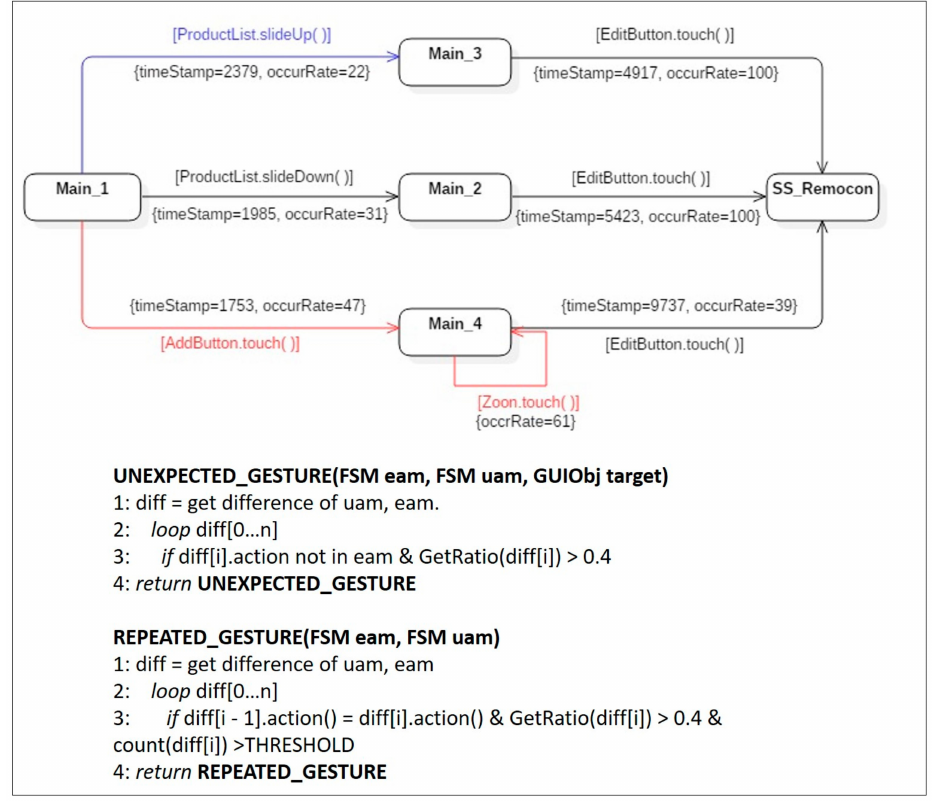
Figure 10. An instance of a user activity model, including bad symptom type 2 and type